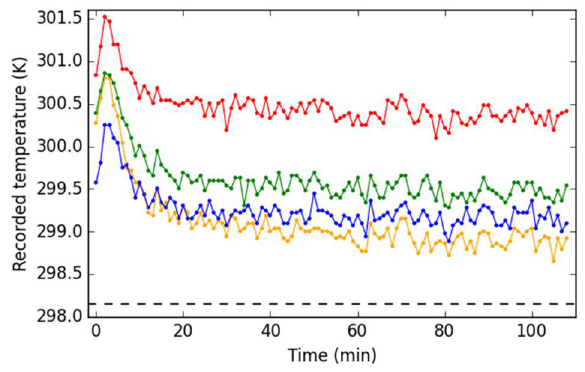
Figure 4. Temperature readings over time of a blackbody at 298.15 K (dashed line), as recorded by sample pixels from the image centre (blue), top left corner (orange), top right corner (red), and bottom right corner (green).